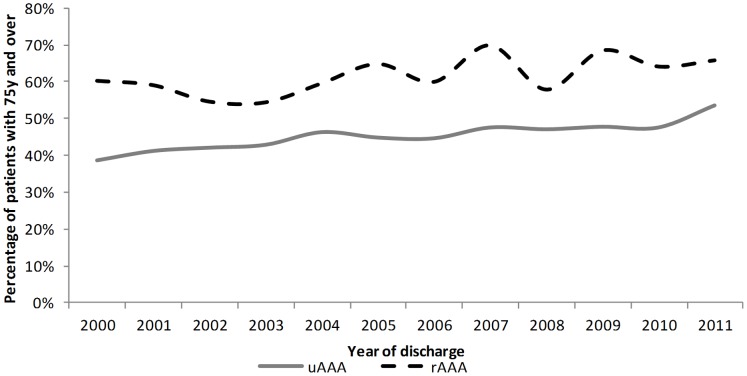
Percentage of patients 75 years and over.